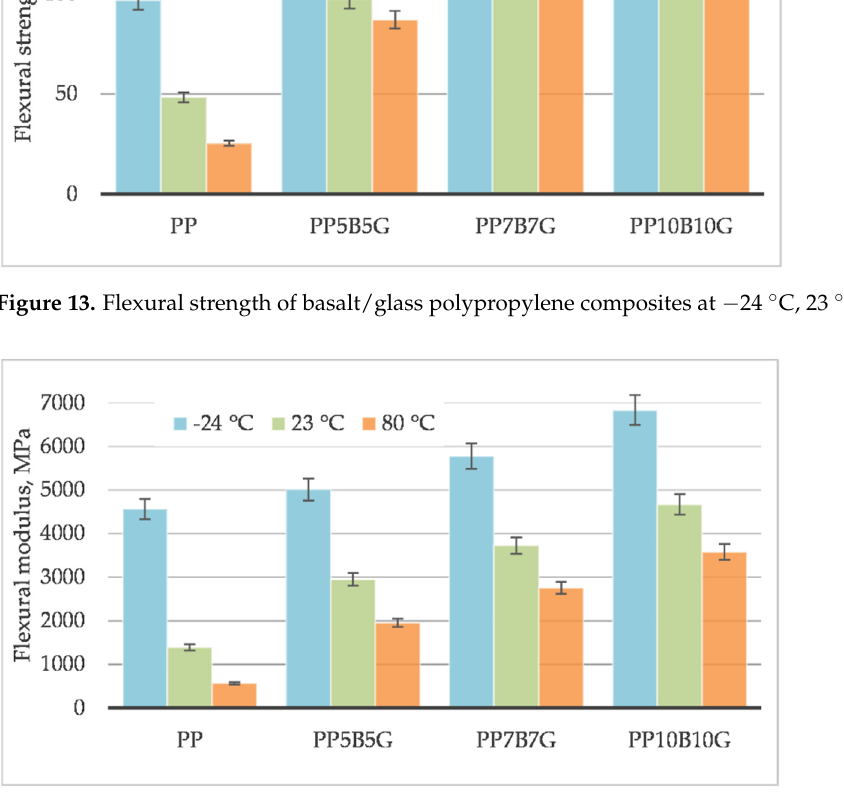
Figure 14. Flexural modulus of basalt/glass polypropylene composites at − 24 °C, 23 °C and 80 °C.